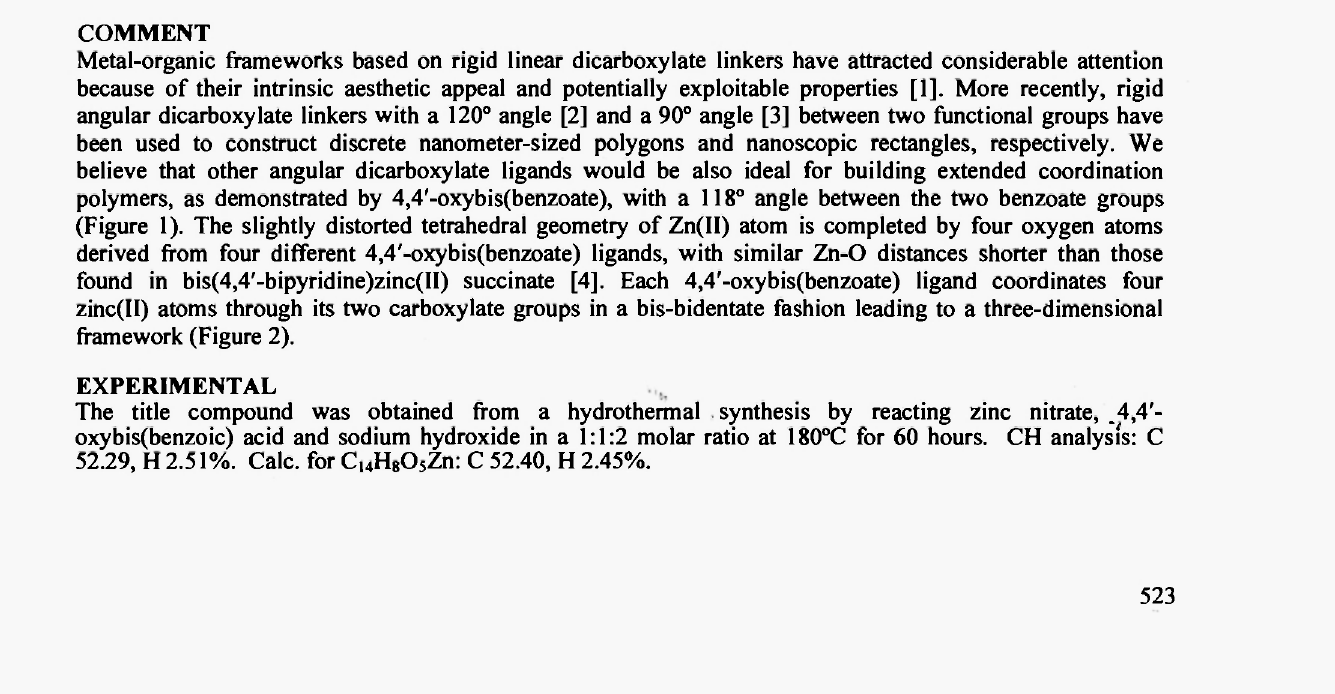
Figure 1. ORTEP plot of the title complex at the 50% probability level. Selected bond distances and angles: Znl—Ol = 1.971(3), Znl—02A = 1.978(3), Znl—03B = 1.953(3), Znl—04C = 1.945(3) Ä; 01—Znl—02A= 105.7(1), Ol—Znl—03B= 114.1(1), Ol—Znl—04C= 103.3(1), 02A—Znl—03B = 107.8(1), 02A—Znl—04C = 110.0(1), 03B—Znl—04C = 115.4(2)°. Symmetry transformation: a =